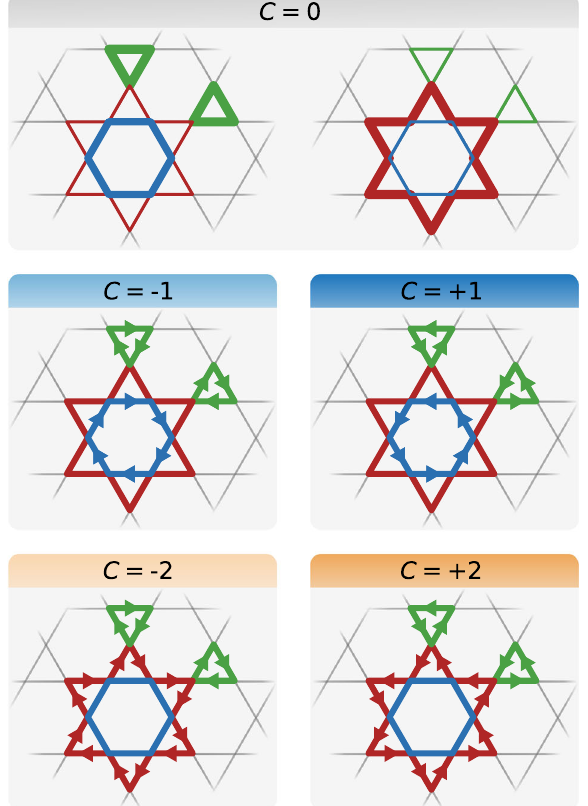
Fig. 4 Insulating phases of the kagome superlattice. Overview of the characteristics of possible insulating phases of the 2 × 2 kagome superlattice with C 6 symmetry that is extracted from an unbiased data set. The hopping parameter t is colored in blue, t 0 and t 0 in red and t 00 in green. t 000 connects different unit cells and are arranged in triangular manner. Arrows illustrate the hopping fl ux direction and the line thickness indicates the relative magnitude of ∣ t ∣ , j t 0 j ¼ j t 00 j and j t 00 j . For C = 1 and C = 2 the hopping fl ux direction is mirrored with respect to C = − 1 and C = − 2, respectively. The handedness of the complex hopping patterns testi fi es the chiral nature of the topological phases.